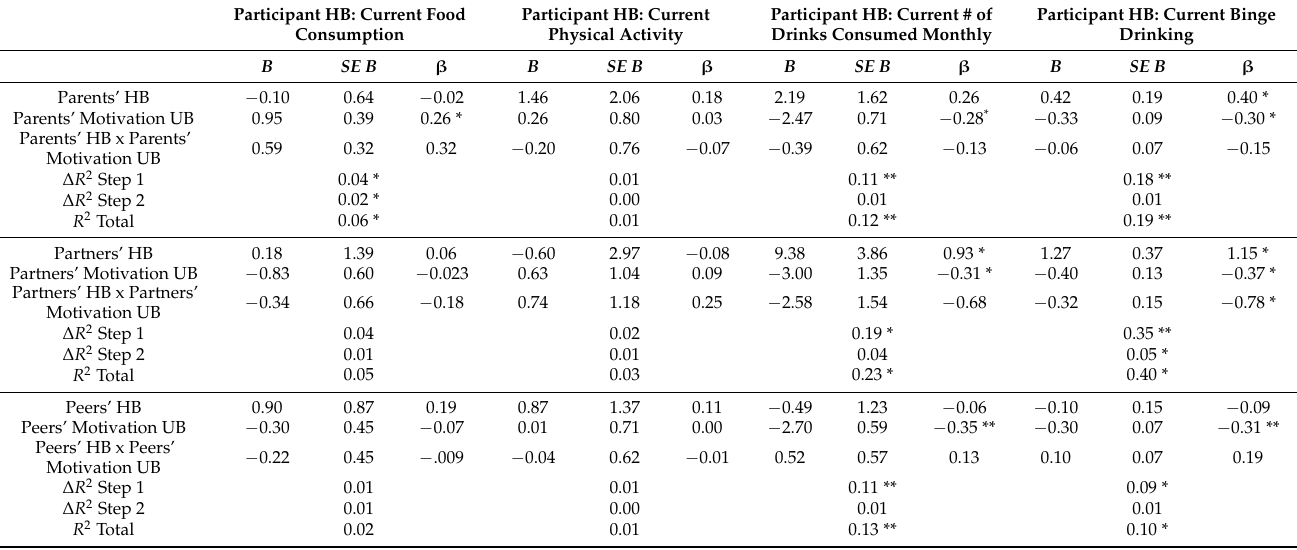
Table 2. Associations of social ties’ efforts to motivate unhealthy behaviors and social ties’ health behavior with students’ current health behavior (Multiple regression analysis).